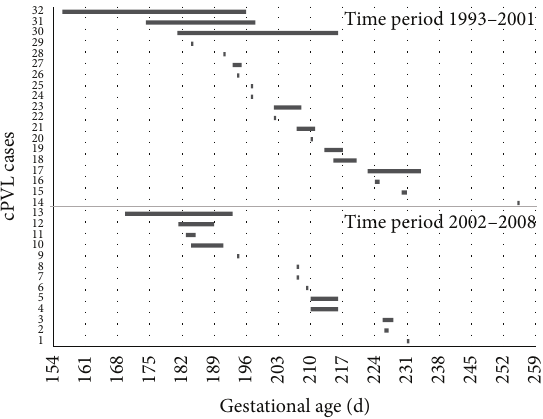
Figure 2: Data from 32 cPVL cases in two time periods. Each bar represents a pregnancy with pPROM-delivery interval beginning with gestational age of